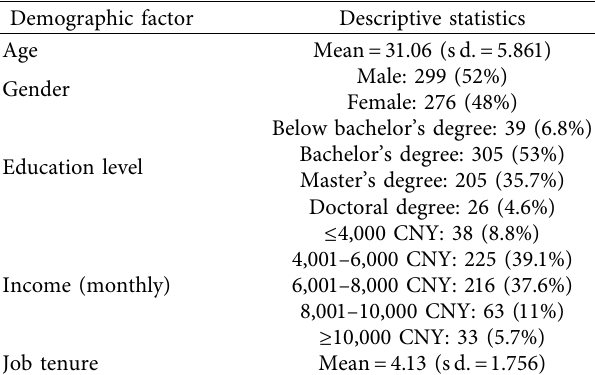
Figure 2: Conceptual model. Table 1: Descriptive statistics of the